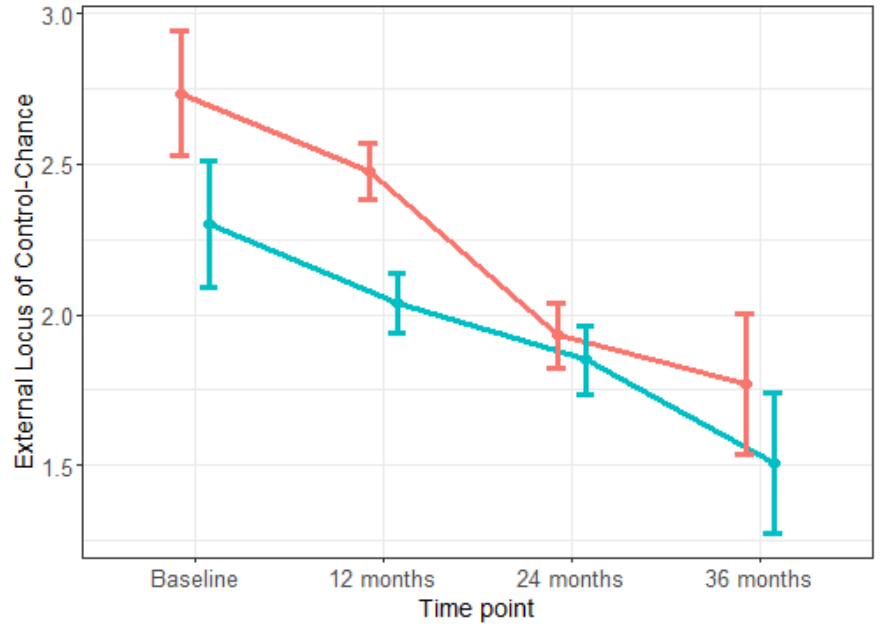
Figure 1. Health Literacy and Change over Time in External Locus of Control—Chance. The figure displays the association of baseline health literacy with change over time in external locus of control—chance, adjusted for parent’s age and income as well as child’s gender. The two lines depict endorsement of the belief that children’s oral health is a matter of chance in two group: parents with health literacy levels that are at or below the median for the sample at baseline and parents whose health literacy levels are above the median for the sample at